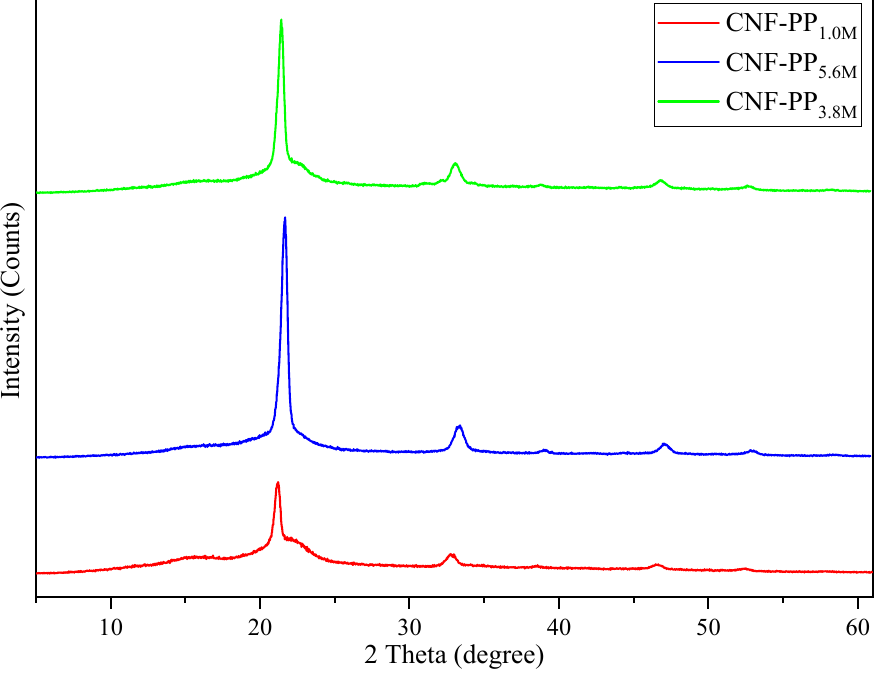
Figure 3. X-ray di ff raction patterns of CNF-PP 1.0M , CNF-PP 3.8M and CNF-PP 5.6M Figure 3. X-ray diffraction patterns of CNF-PP 1.0M , CNF-PP 3.8M and CNF-PP 5.6M .